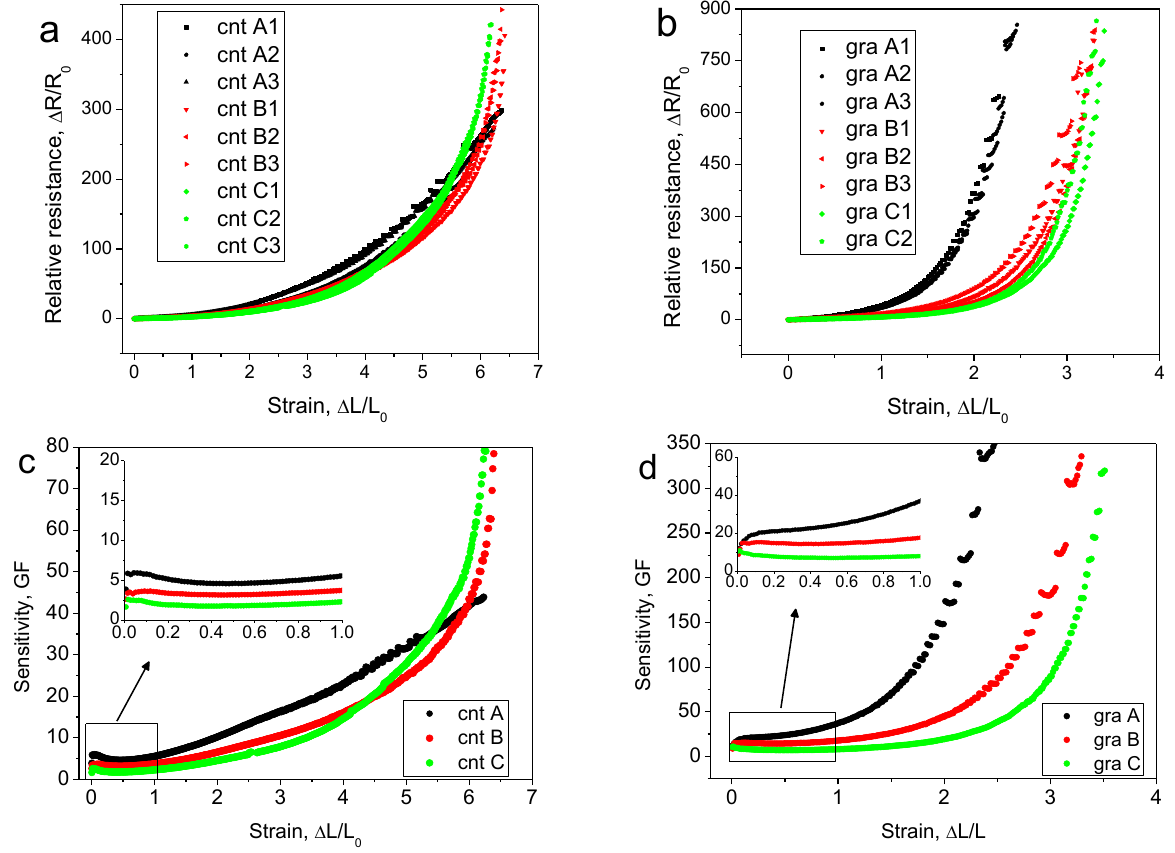
Figure 5. Size dependent sensitivity: ( a ) MWCNT sensors with dimensions (width × length) of 10 × 20 mm (A1, A2, A3); 10 × 10 mm (B1, B2, B3); and 10 × 5 mm (C1, C2, C3); ( b ) Graphite sensors with dimensions (width × length) of 10 × 20 mm (A1, A2, A3); 10 × 10 mm (B1, B2, B3); 10 × 5 mm (C1, C2); ( c , d ) Sensitivity versus strain curves for MWCNT and graphite sensors with dimensions of 10 × 20 mm (A), 10 × 10 mm (B), and 10 × 5 mm